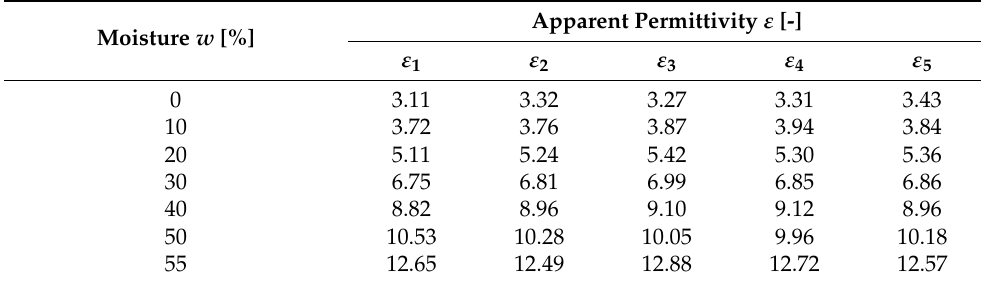
Table 6. Results of the apparent permittivity ε measurements with the S2 surface sensor for different values of moisture w ; 600 c.c. sample.